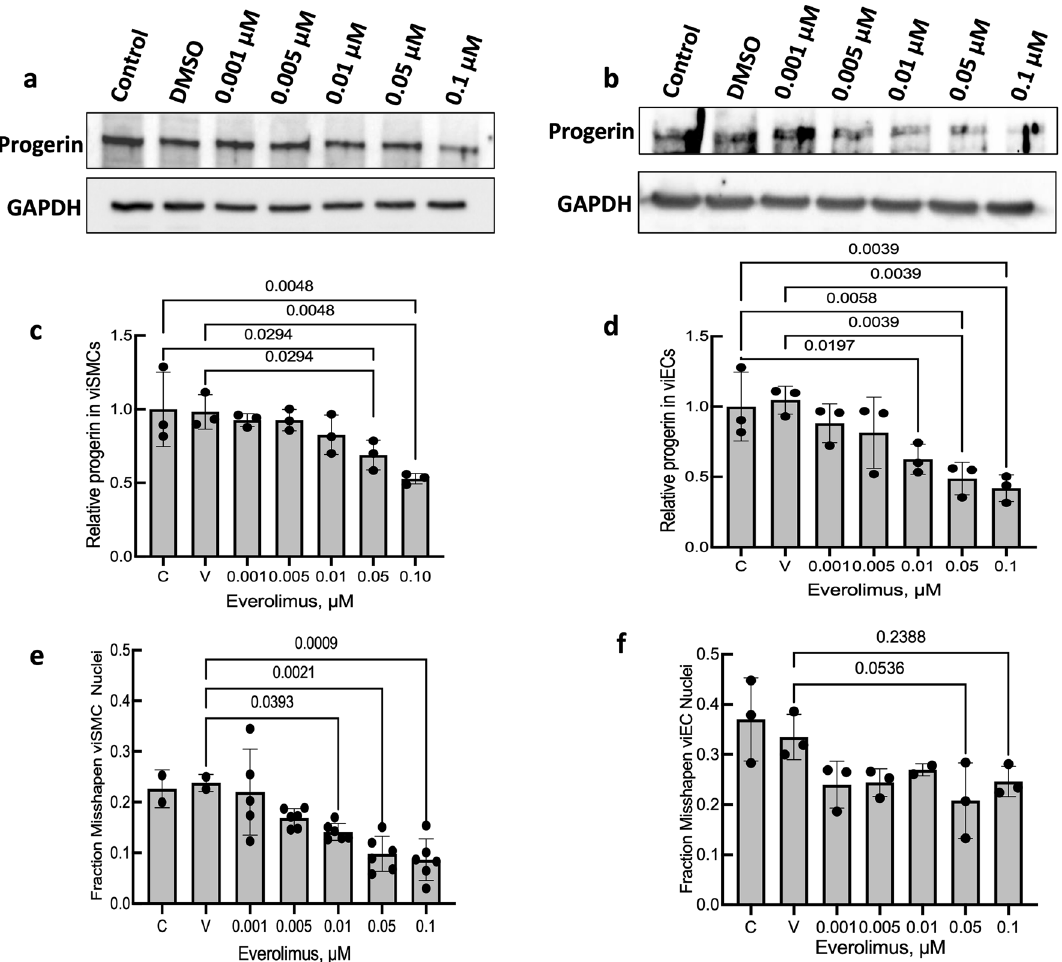
Figure 1. Everolimus reduces progerin expression and misshapen nuclei in HGPS viSMCs and viECs. ( a , b ) Cropped images of Western blot gels of progerin and ( c , d ) quantification in HGPS 167 CL2 viSMCs ( a ) and viECs ( b ) treated with Everolimus (Ev). Entire gels for each of the experiments performed with viSMCs and viECs are shown in Fig. S2. Data presented as fold change progerin expression compared with untreated HGPS control. ‘V’ indicates DMSO vehicle control. ( e, f ) Misshapen nuclei in HGPS 167 CL2 viSMCs ( e ) and viECs ( f ) treated with Everolimus for 7 days. Representative images are shown in Fig. S4. ‘V’ indicates DMSO vehicle control. Data presented as mean ± SD. N = 2–6 experiments per